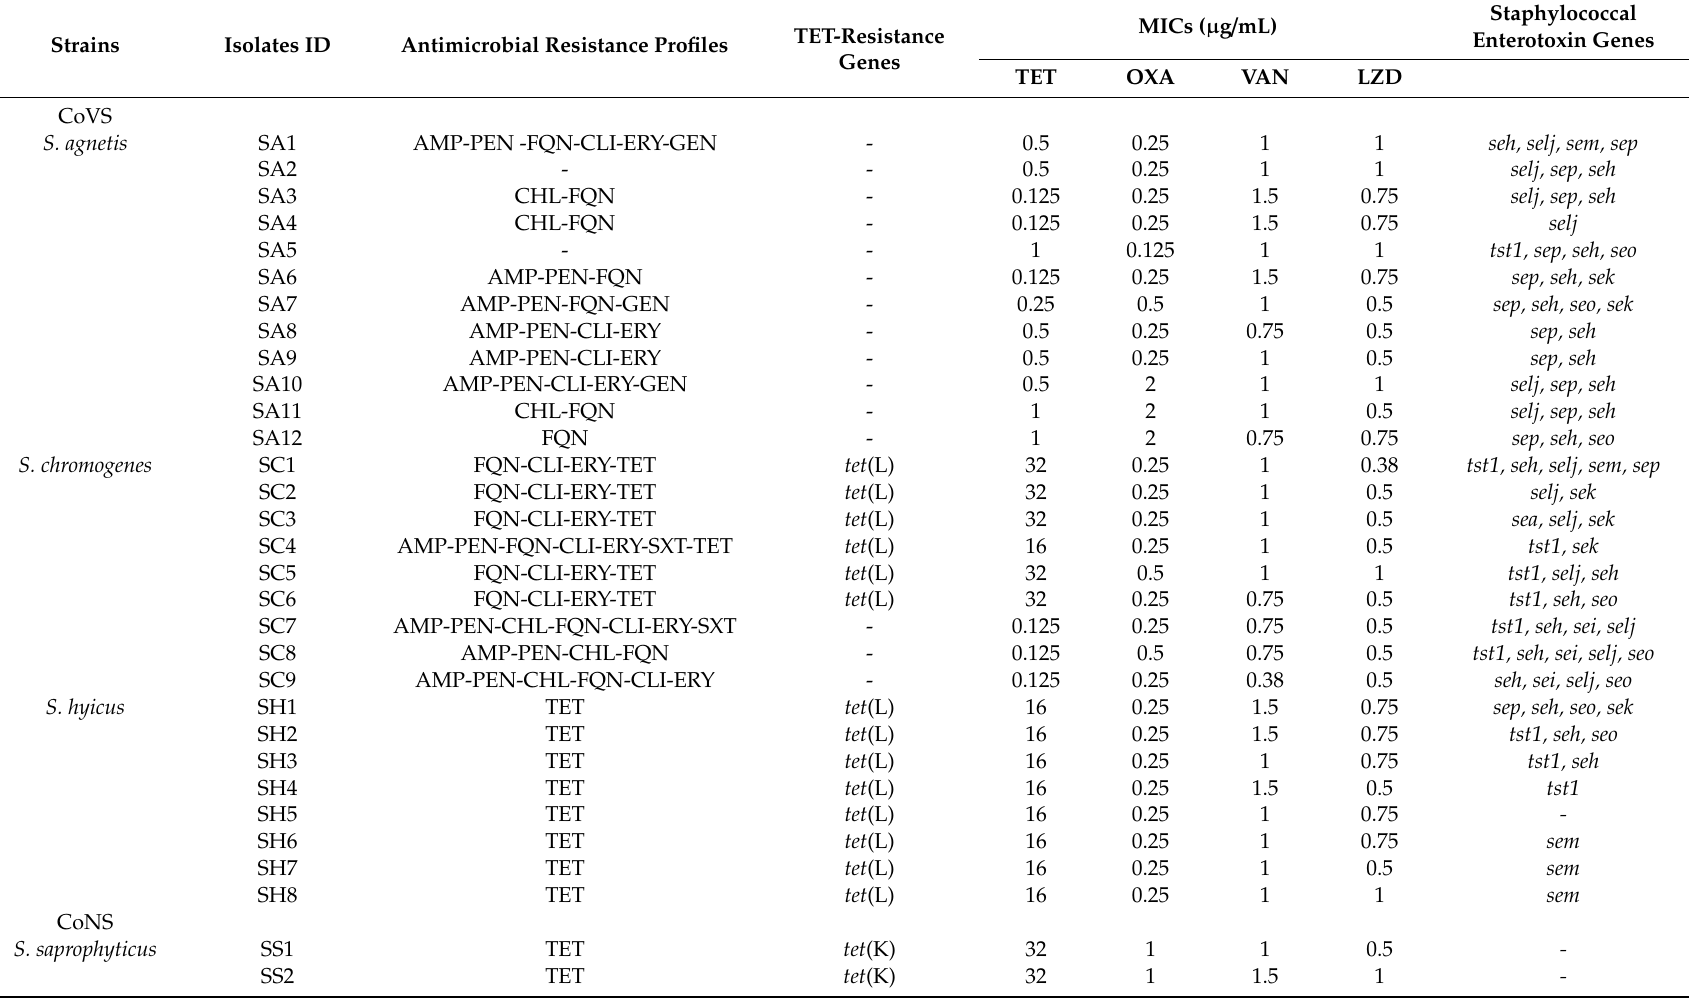
Table 3. Antimicrobial resistance profiles and distribution of enterotoxin genes in non-aureus staphylococci (NAS) strains isolated from retail chicken meat.